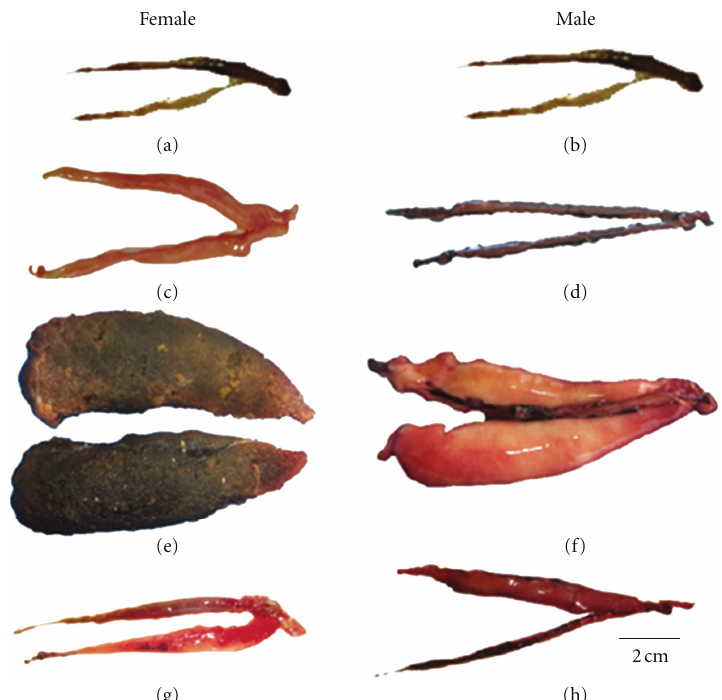
Figure 3: Female and male gonads of Prochilodus brevis, where (a) and (b) represent immature; (c) and (d) maturing; (e) and (f) mature; (g) and (h) spent gonads.